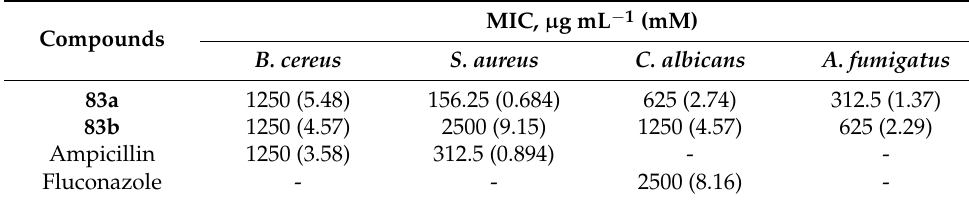
as catalyst (Scheme 22) [76]. The compounds 83a – 83b showed very good antimicrobial fumigatus , compared to the standards used, ampicillin and fluconazole (Table 9). Table 9. Antibacterial and antifungal activities of compounds 83a – 83b .